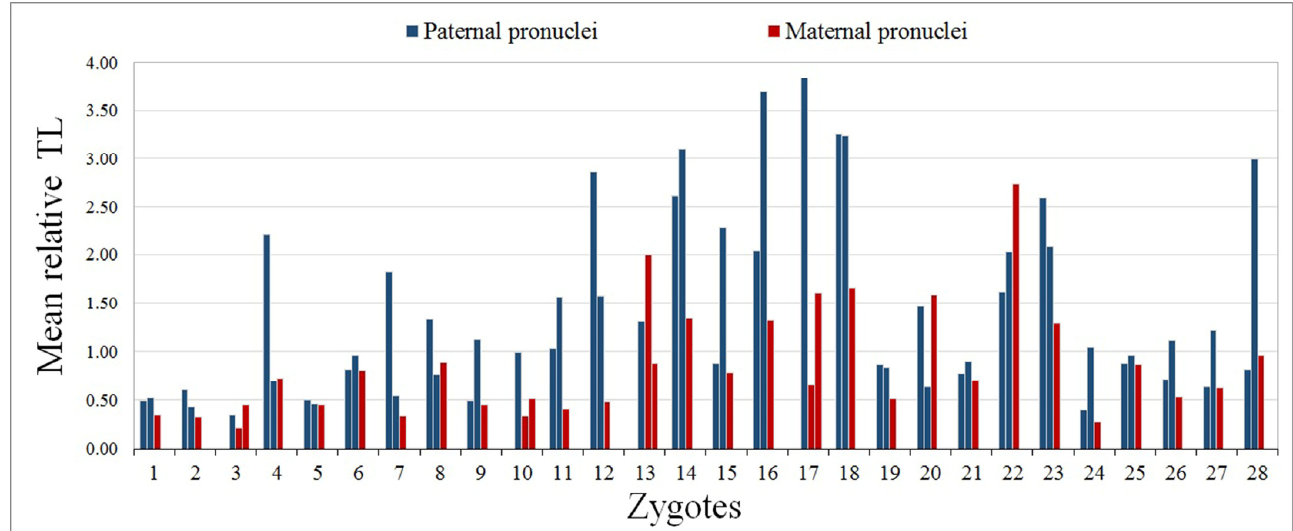
Figure 3. Mean relative telomere lengths (TLs) of chromosome 16 from paternal (blue) and maternal (red) pronuclei of 28 human triploid zygotes. Paternal telomeres are longer than maternal ones (the Wilcoxon test, р < 0.0001).